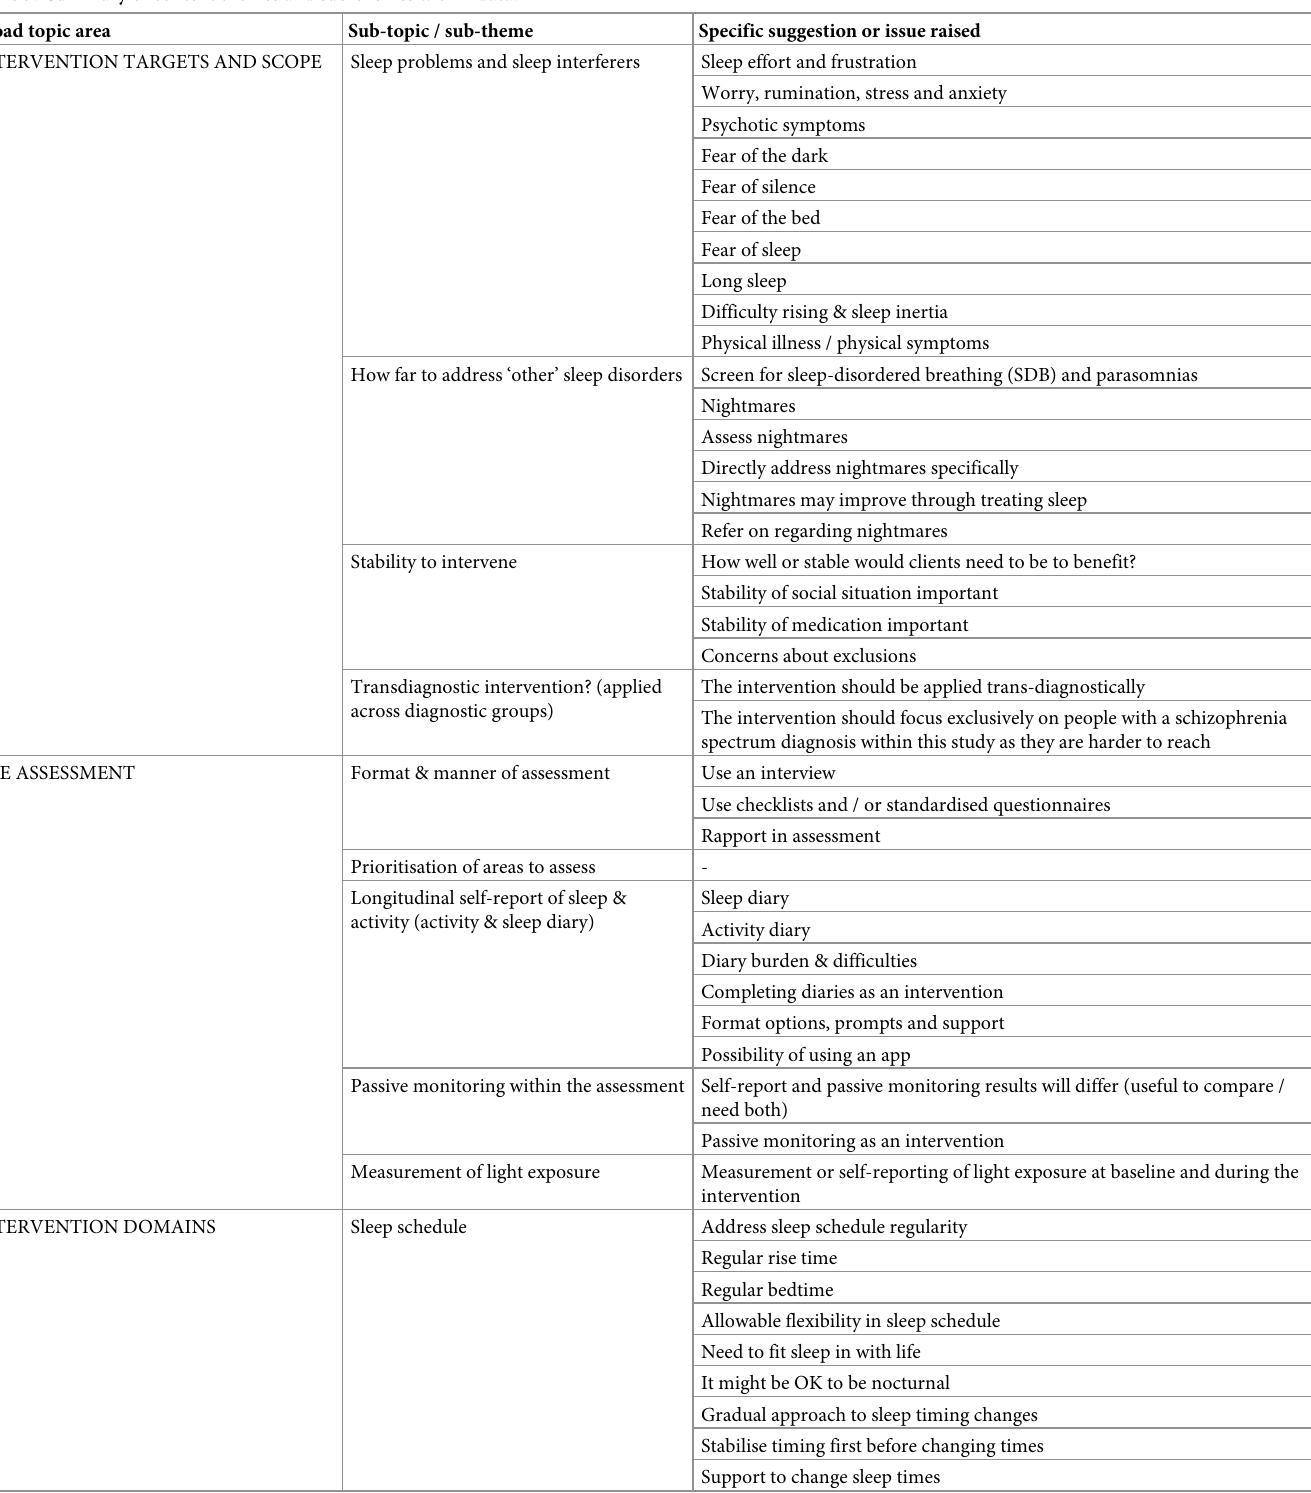
Table 3. Summary of content themes and sub-themes within